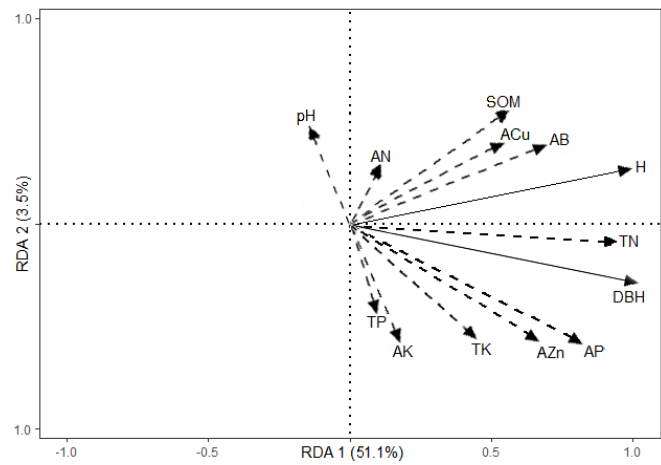
Figure 2. RDA of soil chemical property and trait of E. urophylla × E. grandis. Height of dominant trees (H); Diameter at breast height (DBH); Soil pH value (pH); Soil organic matter content (SOM); Soil total nitrogen (TN); Soil total phosphorus (TP); Soil total potassium (TK); Soil available nitrogen (AN); Soil available phosphorus (AP); Soil available potassium (AK); Available Cu (ACu); Available Zn (AZn); Available boron (AB).